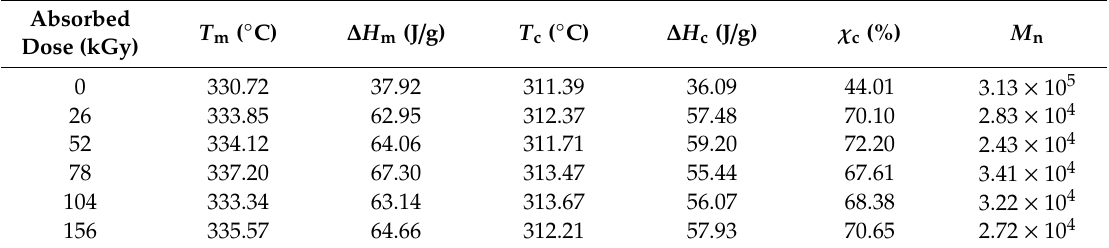
Table 1. Thermal properties of pure PTFE in its initial state and after electron beam irradiation.